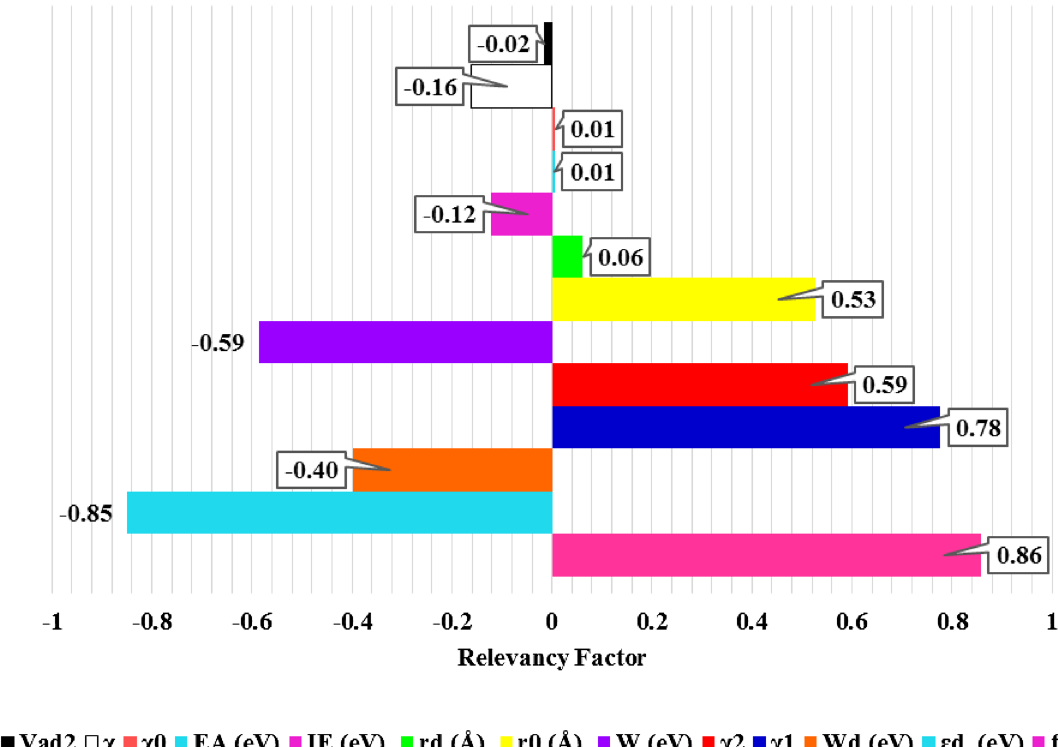
Figure 5. Analysis of sensitivity of the input parameters for *CO adsorption energy on the alloy surfaces.